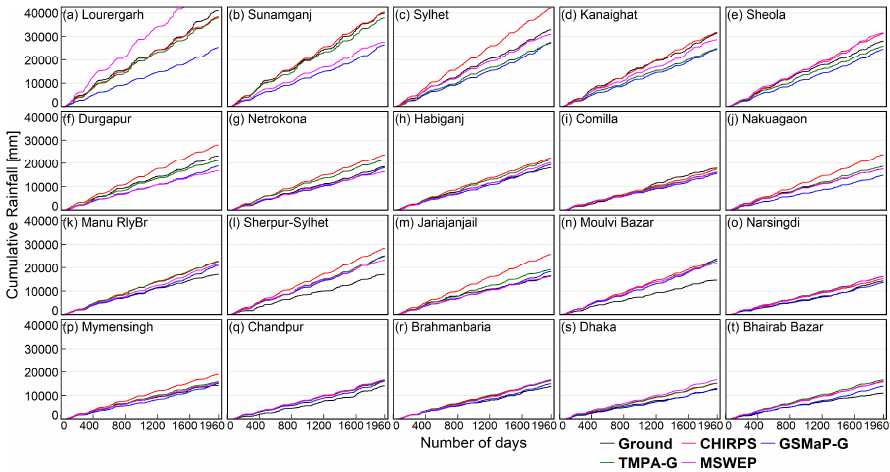
Figure 4. Cumulative rainfall of daily estimates calculated for the ground gauges and GSRPs throughout the wet season (March–October) of the study period (2009–2016), at 20 rain-gauge stations ( a – t ) located within the Bangladesh portion of the Meghna basin. Using the indices based on Equations (1)–(4) in Section 4.1, Figure 5a–t compares daily CHIRPS, GSMaP-G, TMPA-G, and MSWEP estimates for the wet seasons during the entire study period against the daily ground rainfall measurements at 20 rain-gauge stations. The results once again show varying performance for daily estimates of each product. According to the calculated statistics, each product performs differently, resulting in both positive and negative relative biases (RB) in extreme- as well as low-rainfall areas. The accumulated errors (i.e., NMSE and RMSE) for each product result in high magnitudes at all stations and indicate no significant disparities among the products. The errors of agreement (the calculated CCs) show very low coherence for CHIRPS and slightly better (but still low) coherence for the other three products at all gauge